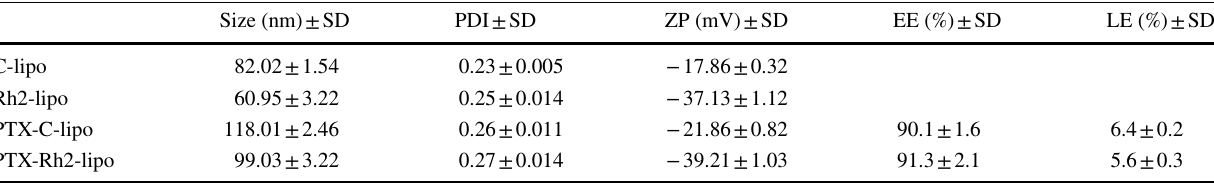
Table 1 Characterization of different liposomes ( n = 3; mean ±